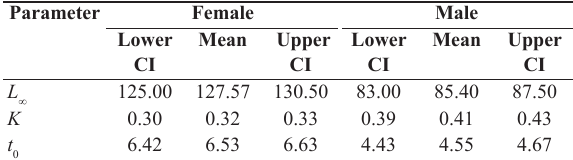
Figure 6. Individual growth curves (interpreted by four differ - ent models) of Pacific hake, Merluccius productus , in the Gulf of California. Table 5. Logistic model, 95% confidence intervals (CI) of the growth parameters of the Pacific hake, Merluccius productus , by sex for the Gulf of California